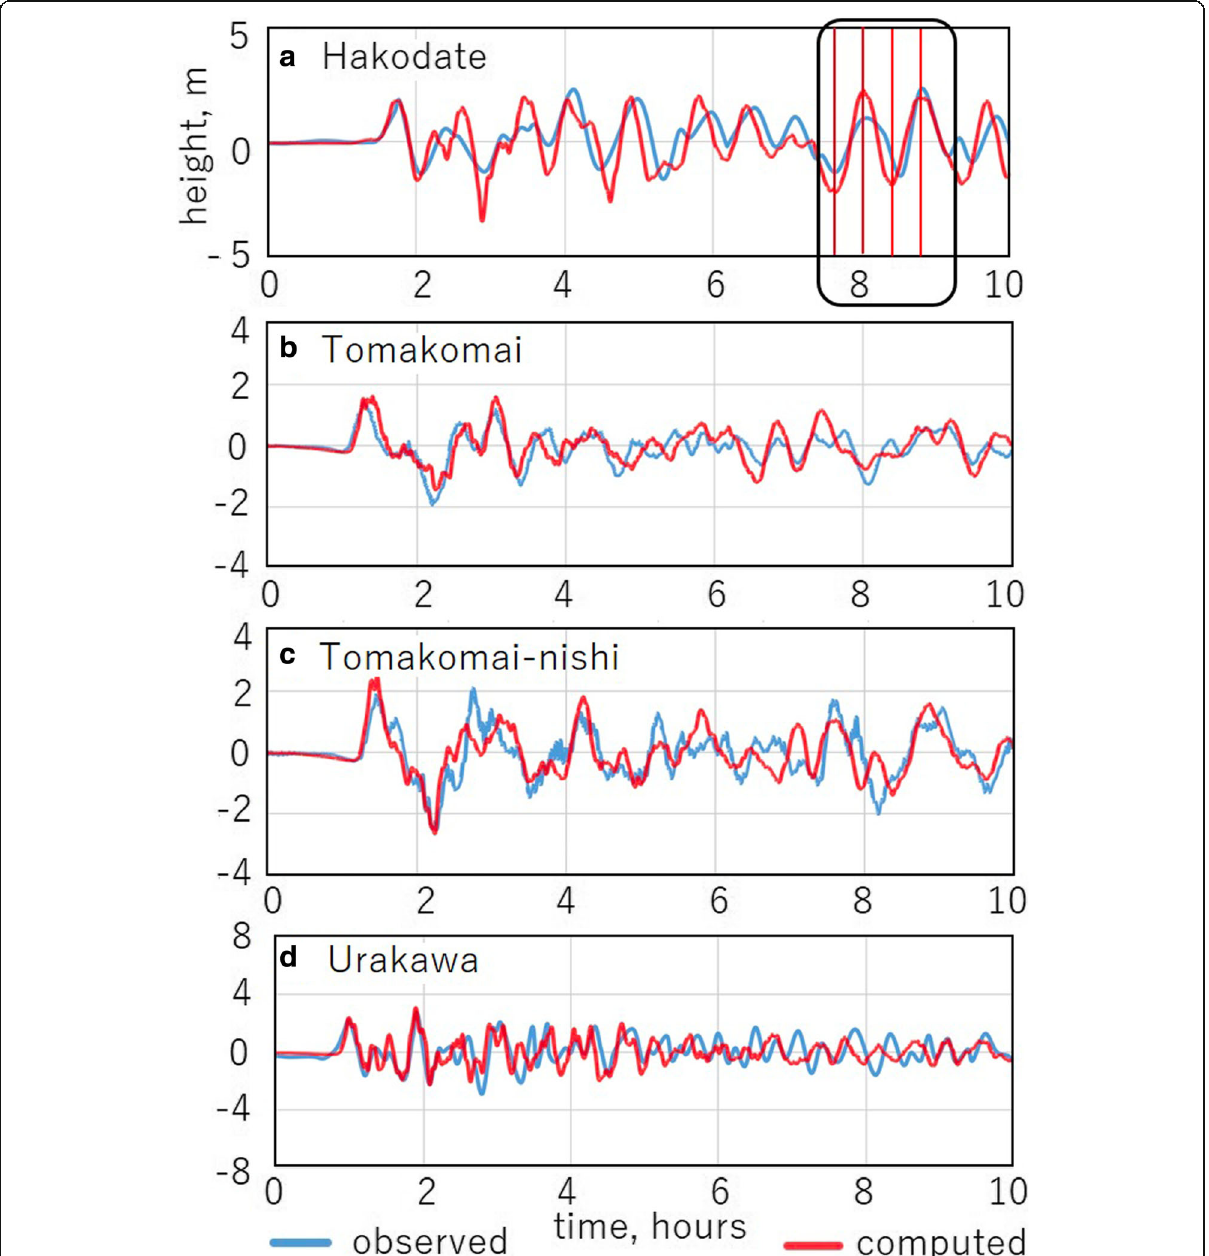
Fig. 3 Comparison of observed (blue) and computed (orange) tsunami waveforms by solving the non-linear shallow water equations with a moving boundary condition at the four tide gauges, in a Hakodate, b Tomakomai, c Tomakomai-nishi, and d Urakawa. The sinusoidal later tsunami phases that arrived in Hakodate between 7.5 and 9.5 h after the earthquake were investigated. Snapshots of the tsunami height distribution were taken 460, 480, 505, and 534 min after the earthquake (red lines) and were analyzed (Fig.